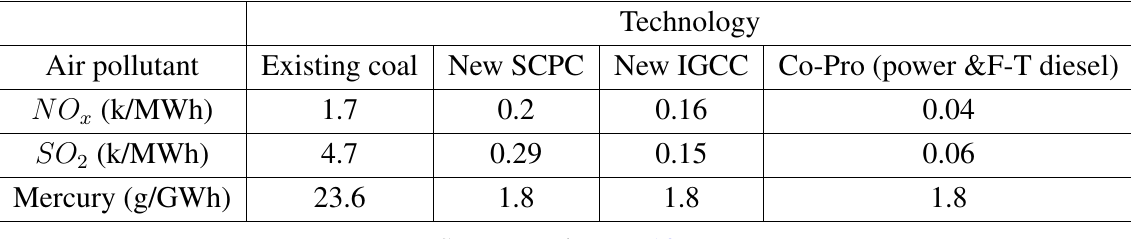
Table 7. Air pollutant comparisons (coal